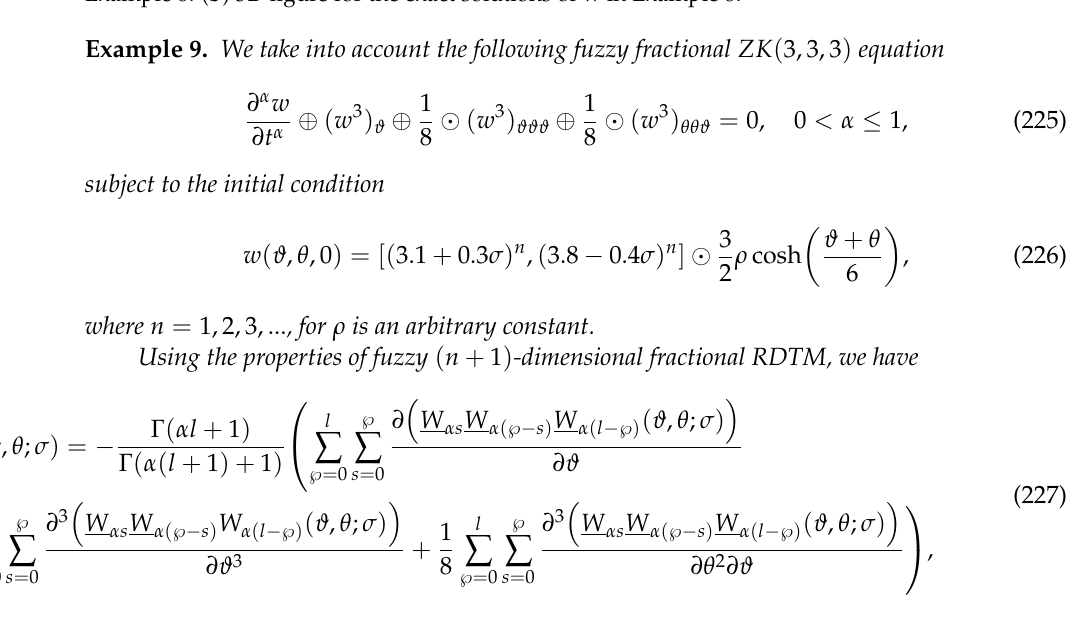
Figure 4. The exact lower and upper solutions of Equation (217) at ϑ = 0.0001, θ = 0.05, t = 0.07, n = 1. ( a ) 2D figure for the exact solutions of fuzzy time-fractional ZK(2, 2, 2) equation of w in Example 8. ( b ) 3D figure for the exact solutions of w in Example